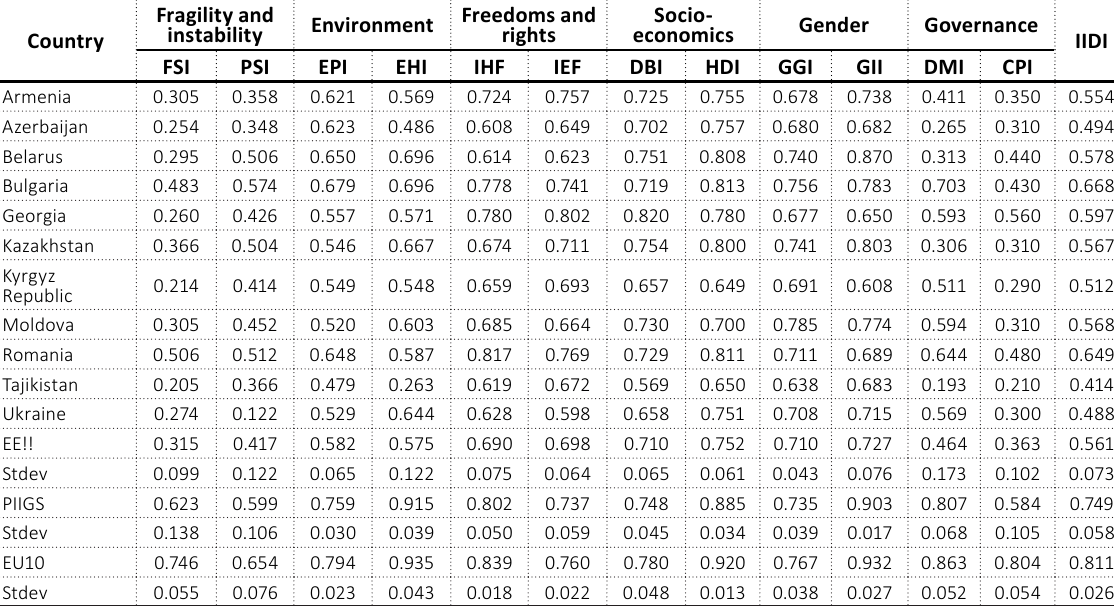
Table 3. Integrated institutional development index